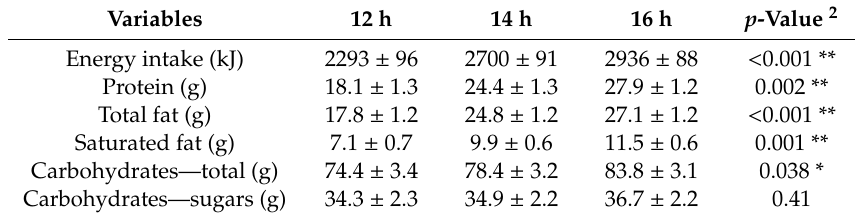
Table 3. Dietary analysis of ad libitum food intake 2 h after the standard breakfast meal. 1.